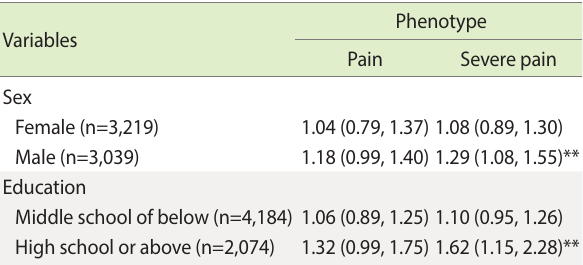
Table 3. Mortality risk according to pain phenotype by sex and edu- cational level 1